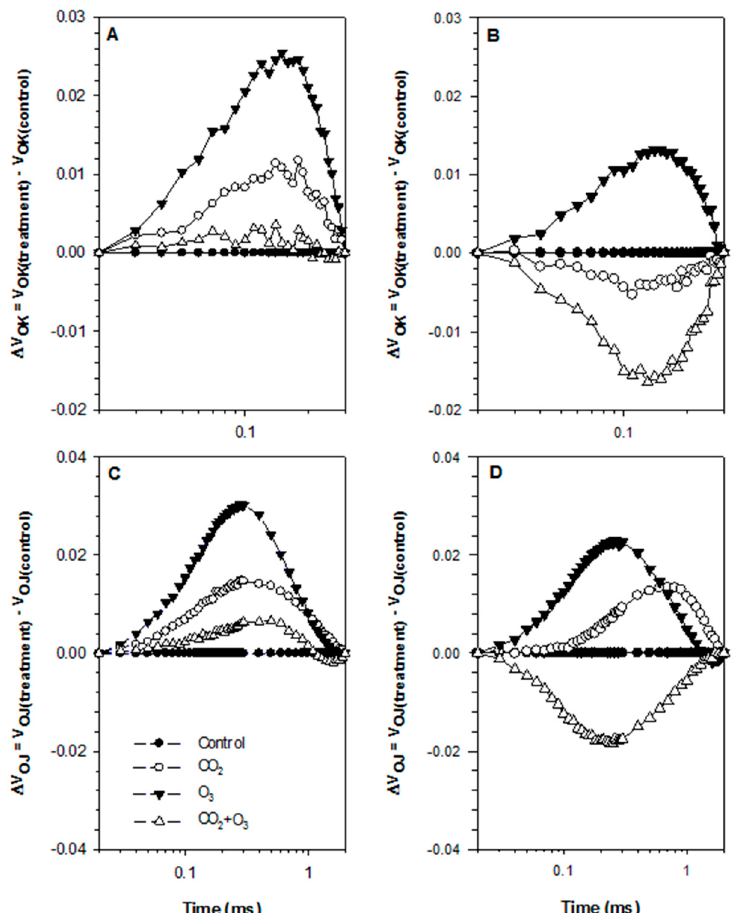
Figure 7. The effect of elevated CO 2 , O 3 and CO 2 +O 3 on differential plots of relative Chl a fluorescence ( Δ V t ) under well-watered ( A and C ) and water-stressed conditions ( B and D ) in leaves of wheat. The data represent the average of all weeks. A – B , Δ V OK = V OK (treatment) − V OK (control) ; C – D , Δ V OJ = V OJ (treatment) − V OJ (control) .